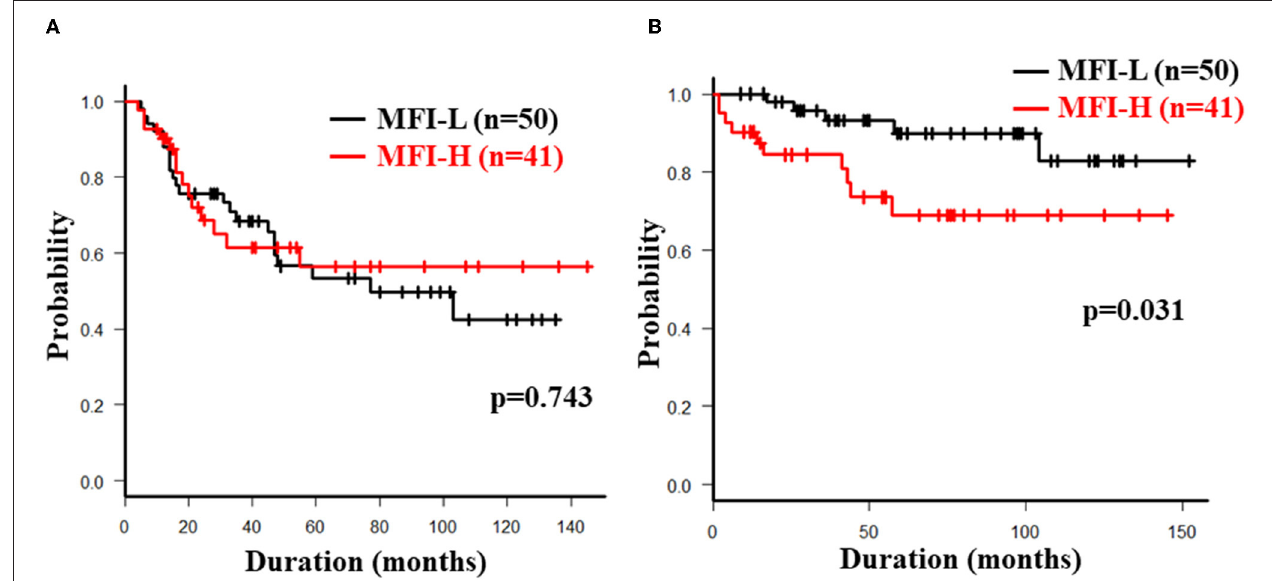
FIGURE 3 | Cumulative secondary failure-free (A) and bowel resection-free (B) rates classified according to the MFI.